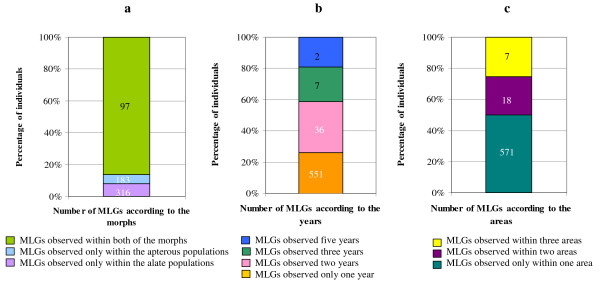
Occurrence of multilocus genotypes in the A. gossypii populations sampled in France and Lesser Antilles. The numbers of multilocus genotypes are shown in the bars and the percentages of individuals exhibiting those multilocus genotypes are shown in the axis y according to a. morphs, b. years and c. areas.